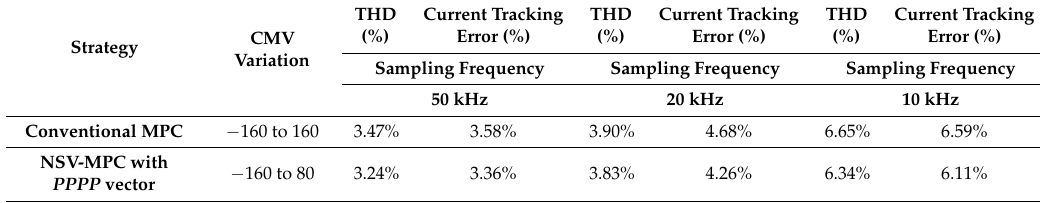
Table 6. CMV, percentage of THD, and current tracking error variation at different sampling